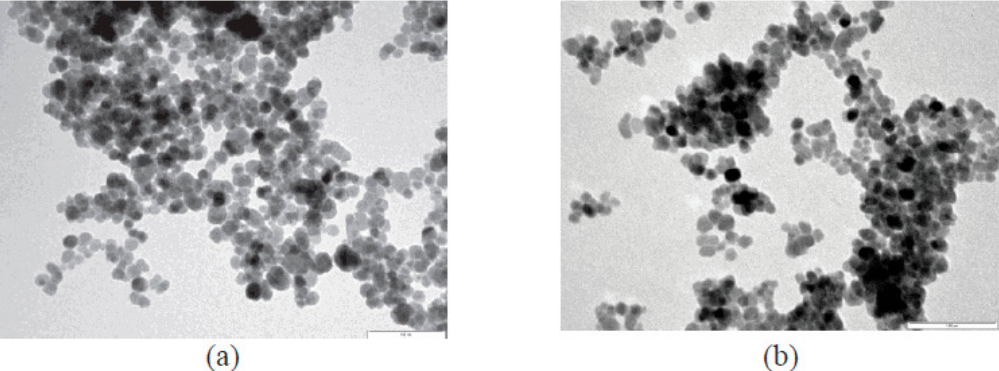
Figure 10. TEM image for ( a ) MNP-1 (bar-size 100 nm) and ( b ) magnetic core-shell nanoparticles based on PPy functionalized with MNP-2. Reprinted with permission from [50].